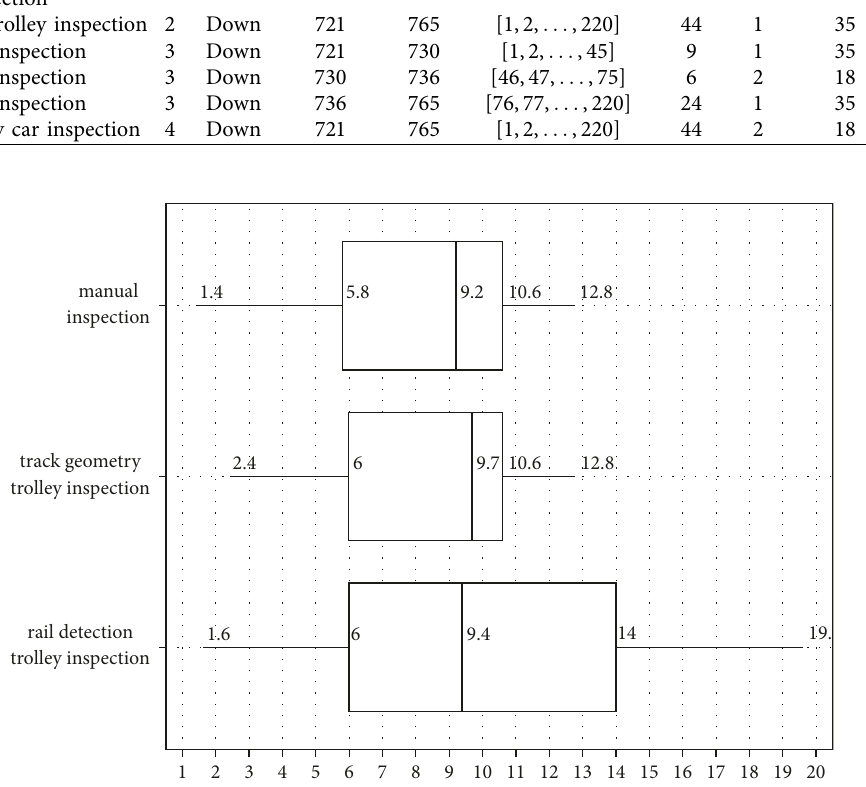
Figure 6: Box plot of activity rates of different inspection